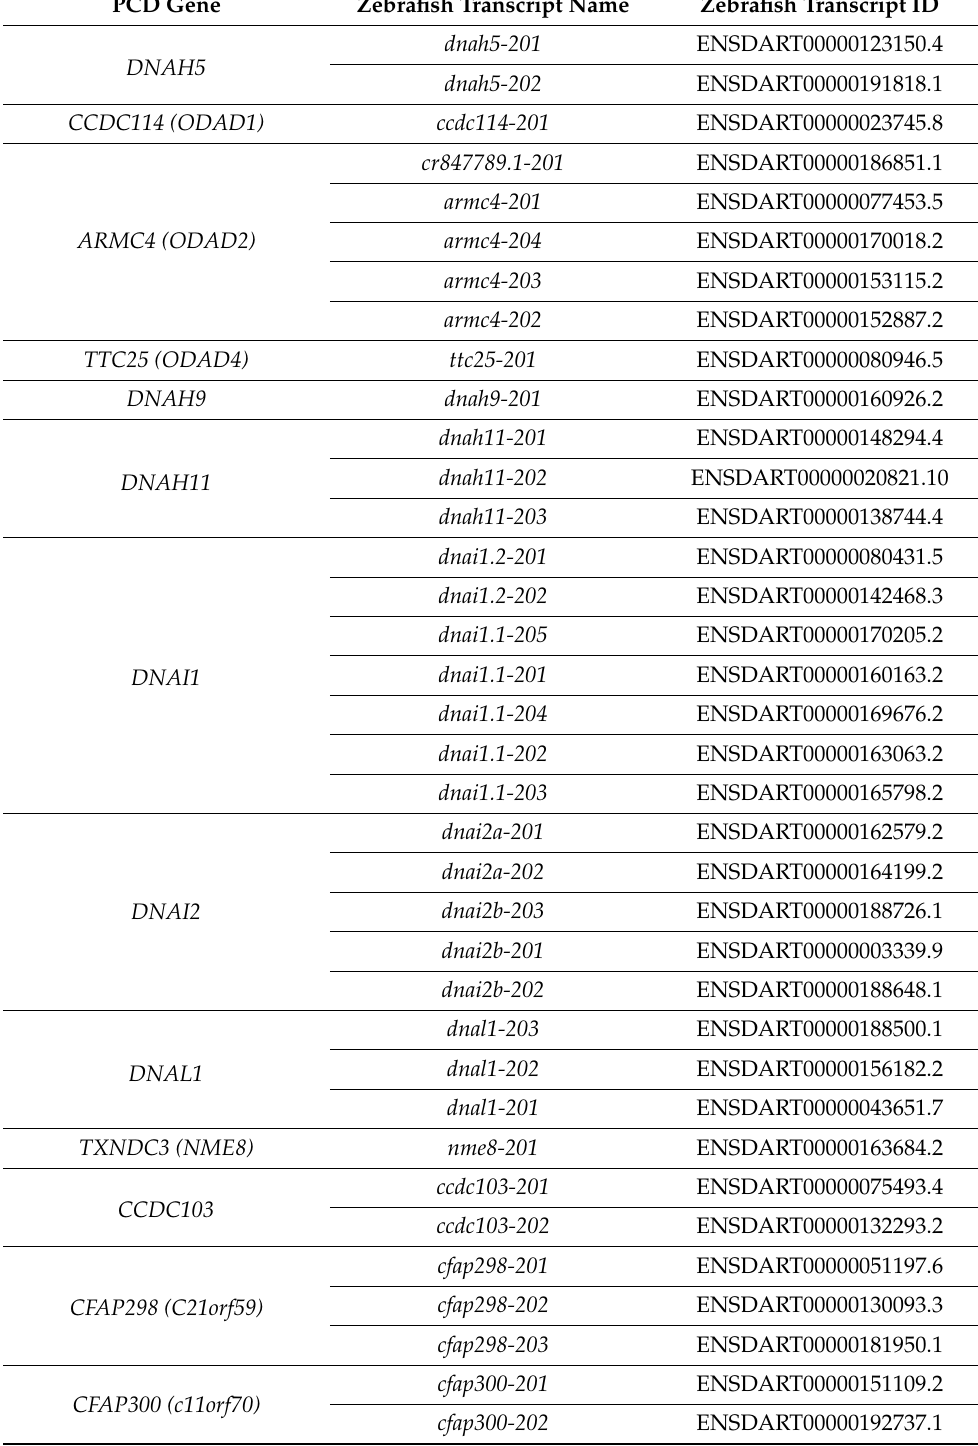
Table 1. Human-Zebrafish homologue PCD genes as described in Ensemble.org